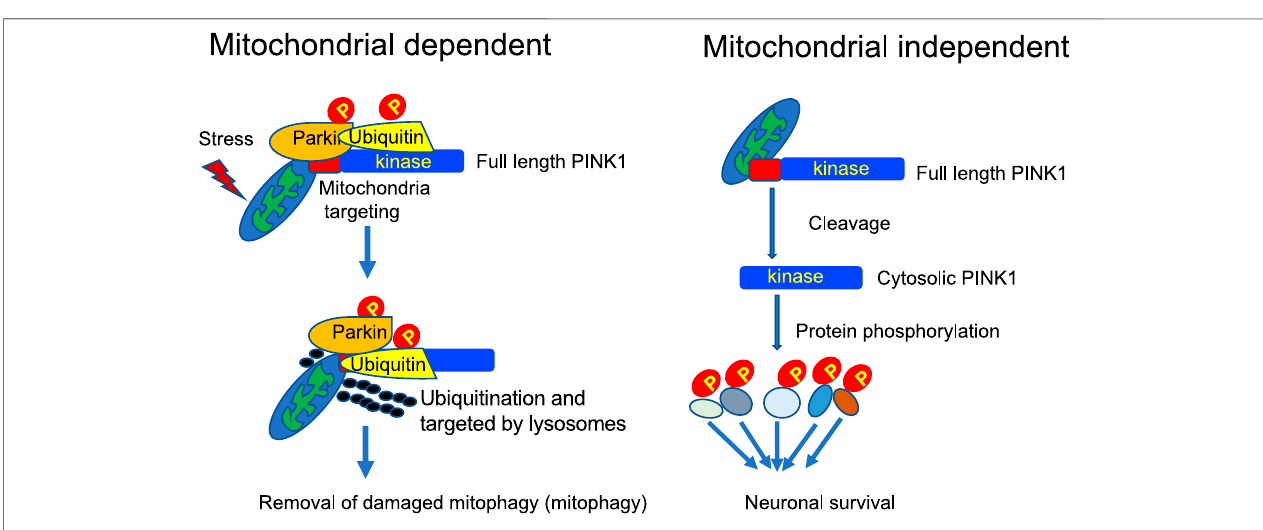
FIGURE 2 | Mitochondrial-dependent and independent functions of PINK1. In the primate brain, PINK1 can phosphorylate a large number of proteins, including those for regulating mitochondrial function, to maintain neuronal survival.